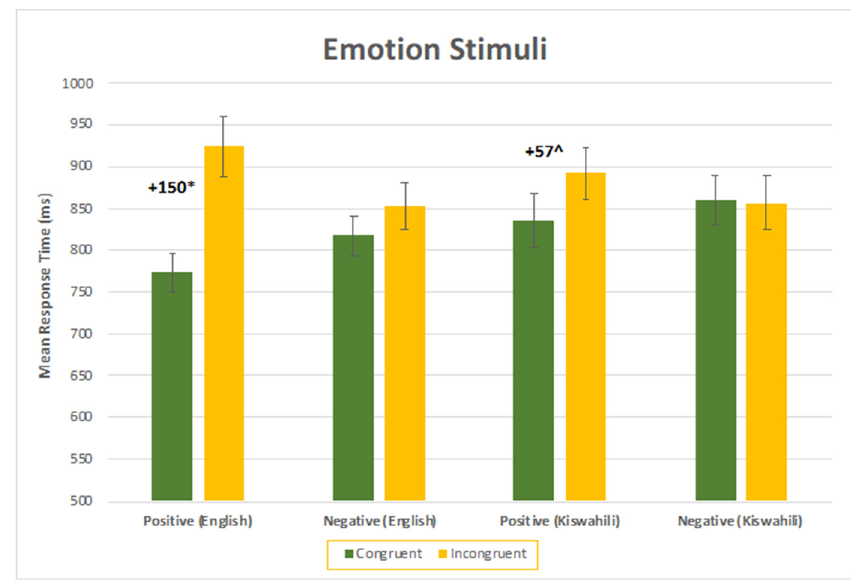
Figure 1. Mean Response times for emotion words. * Indicates p < 0.05, ^ indicates p = 0.10.